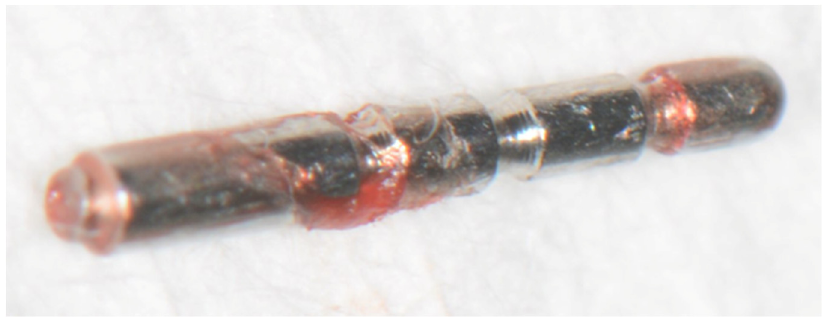
Figure 6. The surgically removed fragment tip of a periodontal probe type AE P OWP.